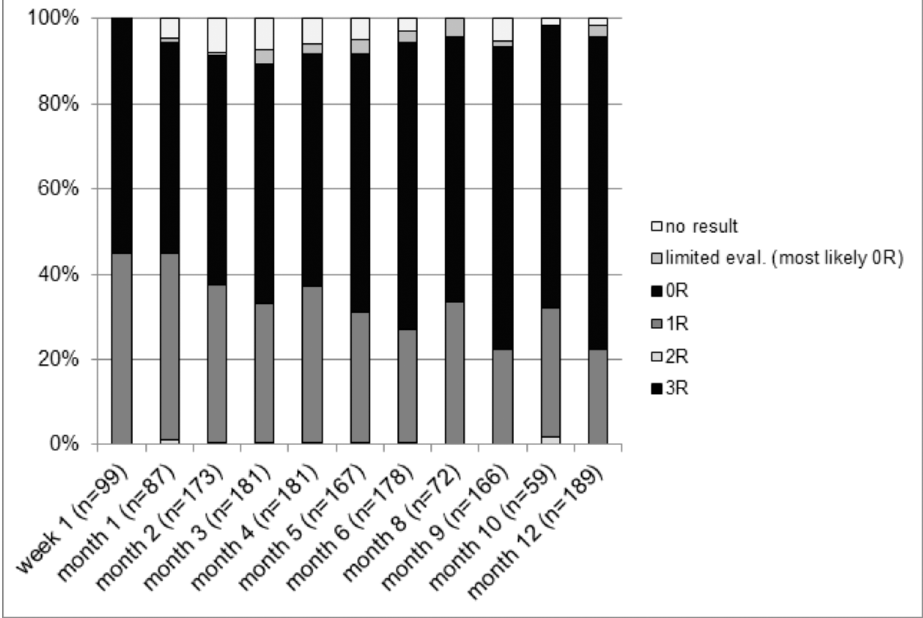
Fig 1. rsEMB results. Results of all rsEMB performed between2004 and 2014 classifiedby pathological gradingand time point.